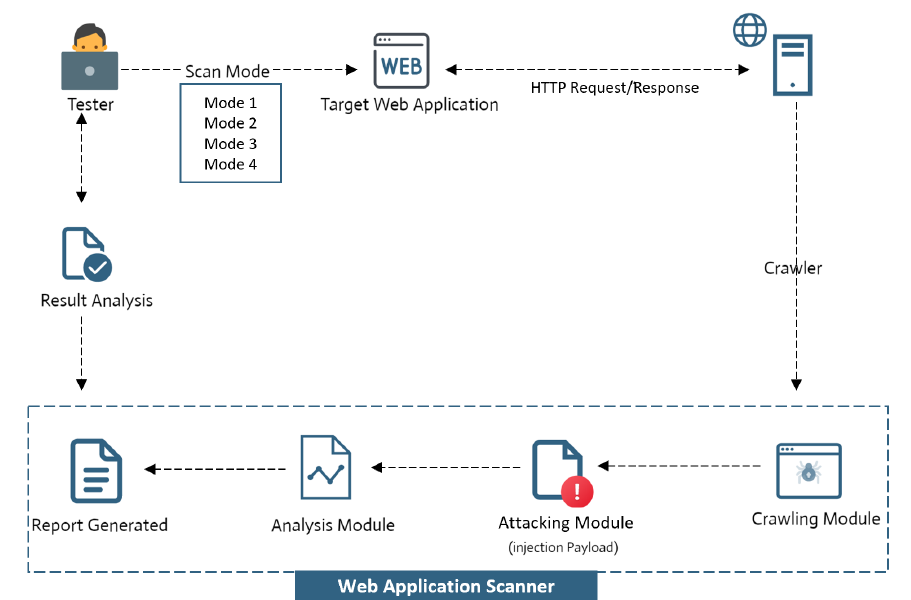
Figure 2. Experimental workflow.